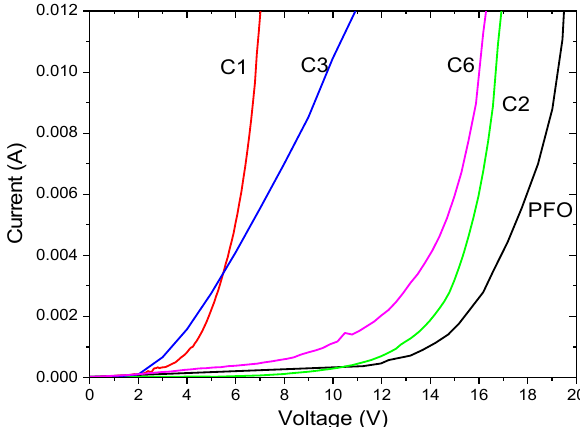
Figure 6. I–V curves for the single-layer device ITO/polymer/Al with PFO, C1, C2, C3, and C6.